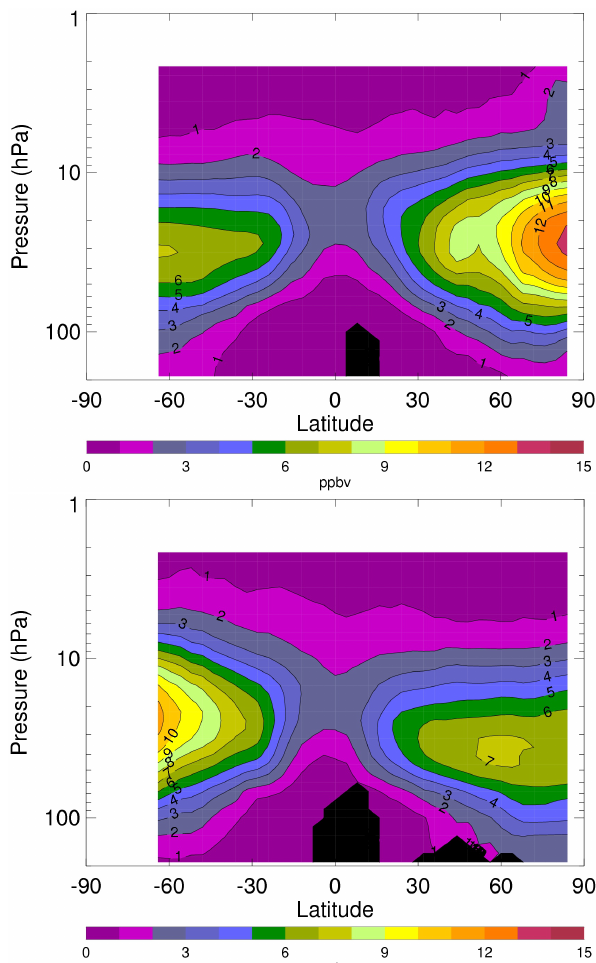
Fig. 1. V6 HNO 3 distributions inppbv for (top) 15 November 1978 and (bottom) 16 May 1979, based on a combination of the profile data from their ascending and descending orbital segments. Orange- to-red colors represent high values and magenta colors are low val- ues; blackened regions indicate where there are no